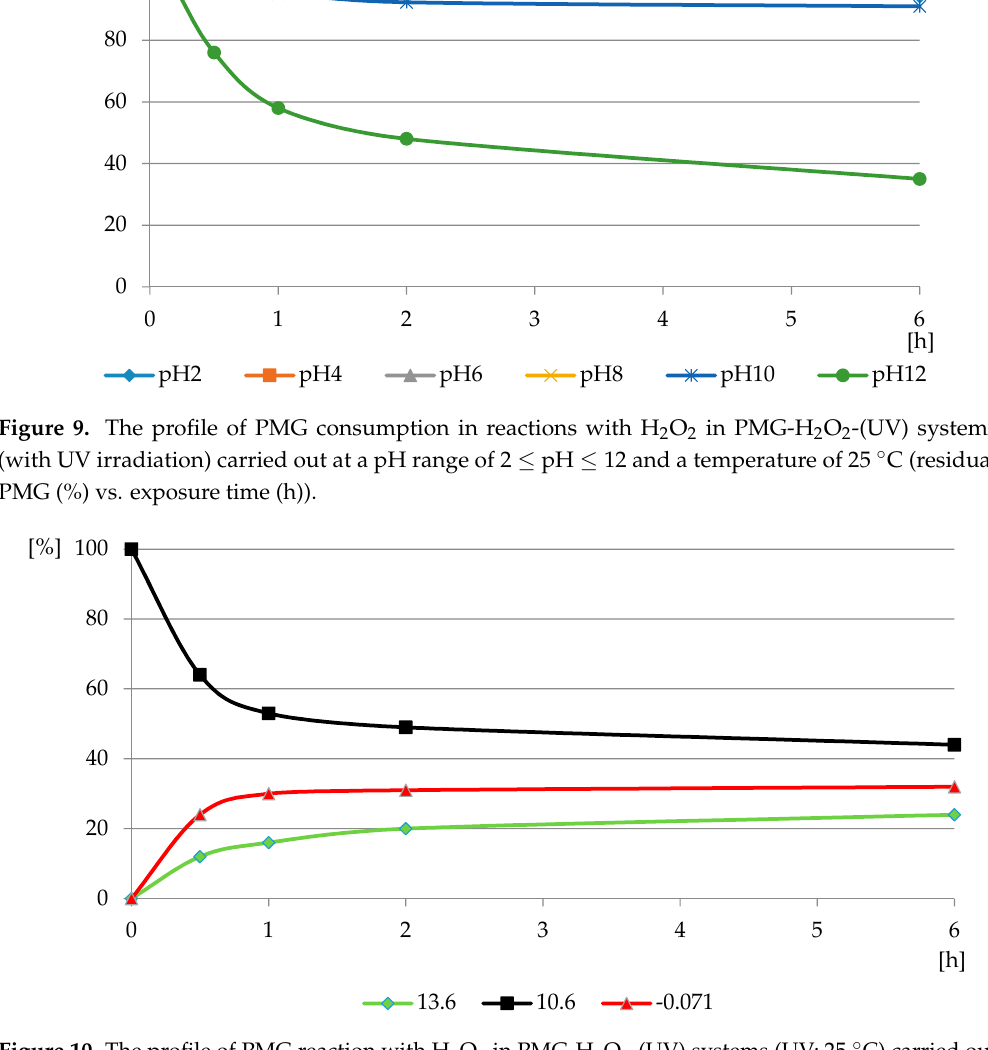
Figure 10. The profile of PMG reaction with H 2 O 2 in PMG-H 2 O 2 -(UV) systems (UV; 25 °C) carried out at pH = 12 (relative P-compounds contribution (Gly P : 13.6 ppm, PMG: 10.6 ppm; P i : − 0.071 ppm) (%) vs. exposition time (h)).